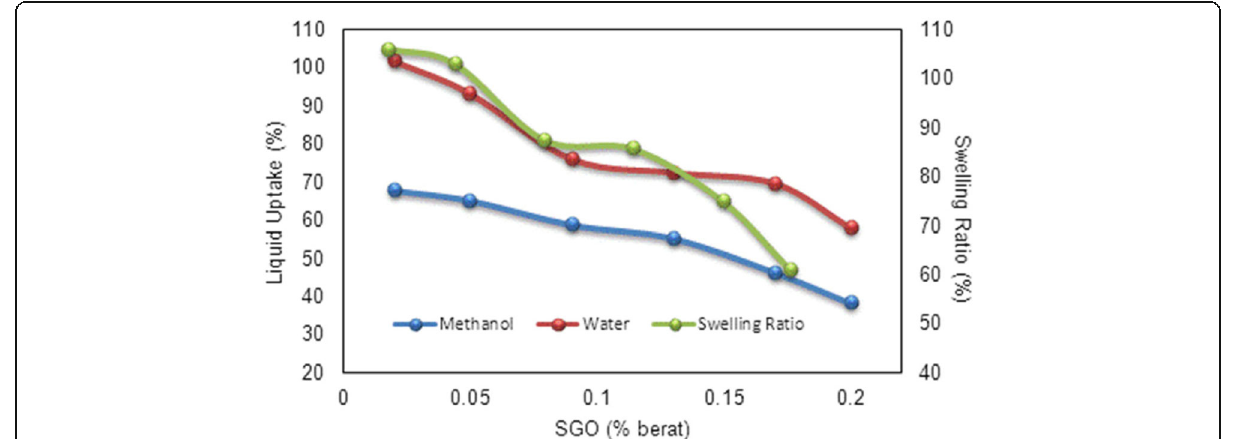
Fig. 9 Liquid uptake and swelling ratio of SA/SGO membrane with wt.% of